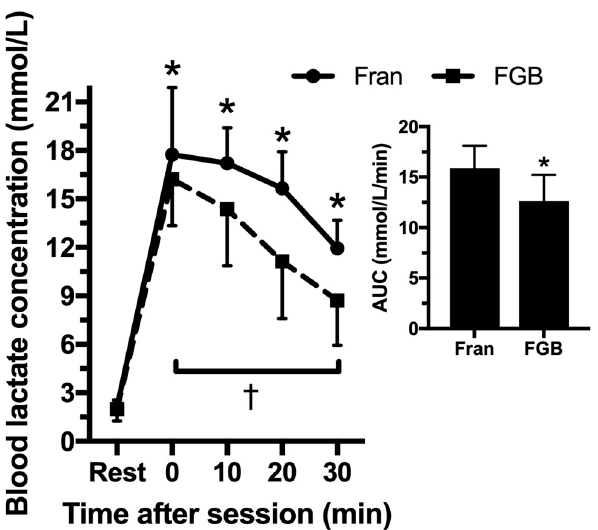
Figure 2. Blood lactate concentration before and after CrossFit ® sessions and area under the curve (AUC) of blood lactate concntration during the 30 min of recovery for both sessions. * p ≤ 0.05 for rest for the two CrossFit ® sessions; † p ≤ 0.05 between CrossFit ® sessions.